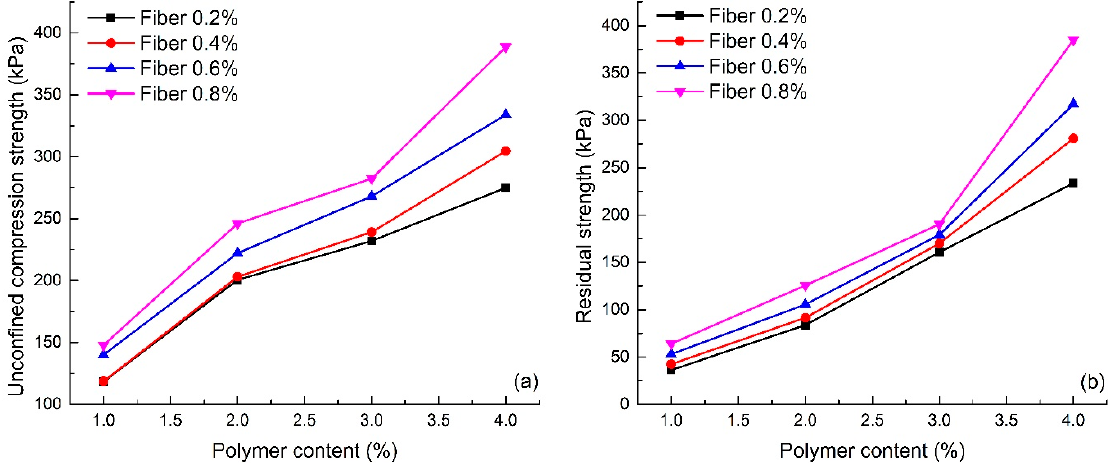
Figure 4. Effect of polymer content on unconfined compression test: ( a ) Unconfined compression strength; ( b ) Residual strength.